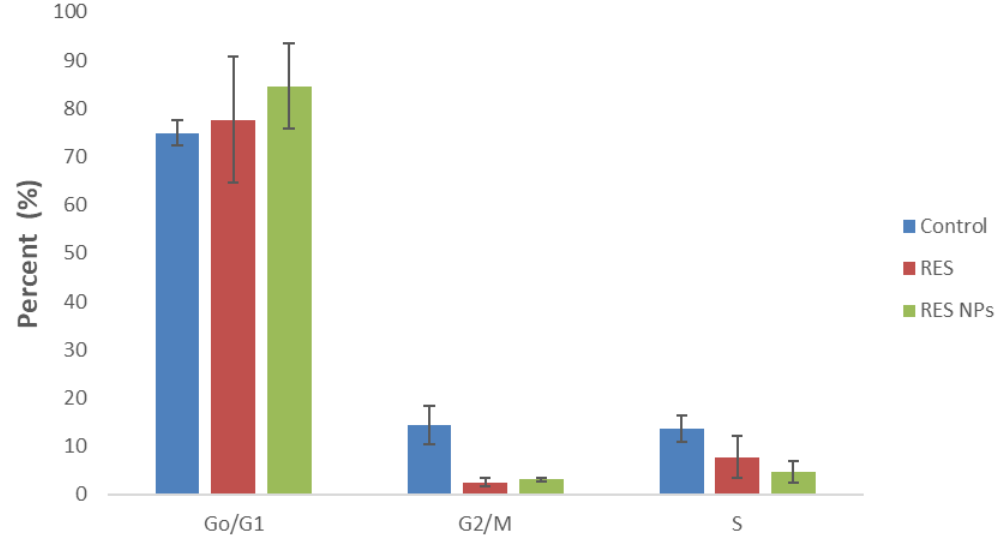
Figure 12. Flow cytometric analysis of the effect of RES and RES NPs in H1299 lung cancer cells at 24 h for cell cycle analysis. The data were analyzed using one-way ANOVA followed by Tukey’s post hoc test. The percentage of cells in each group was compared with control, p < 0.05 indicates a significant difference.